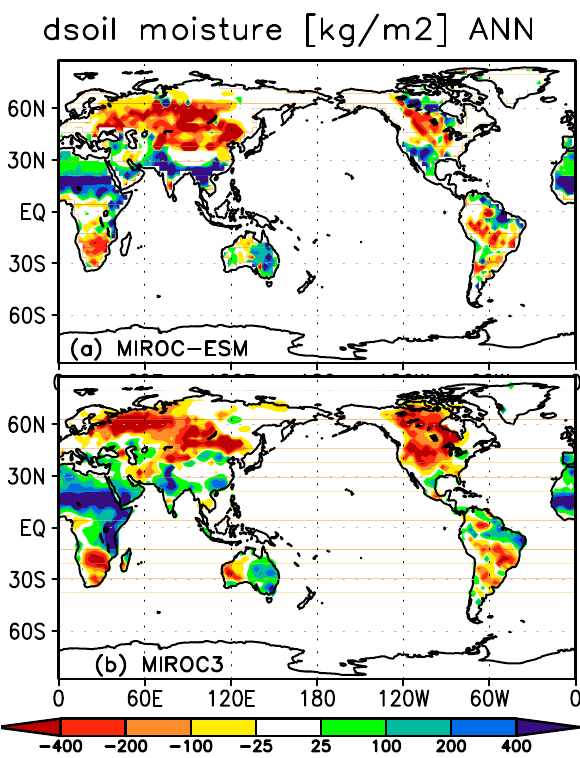
Fig. 6. 6–0ka net soil moisture change (kgm − 2 ) for (a) MIROC- ESM and (b)